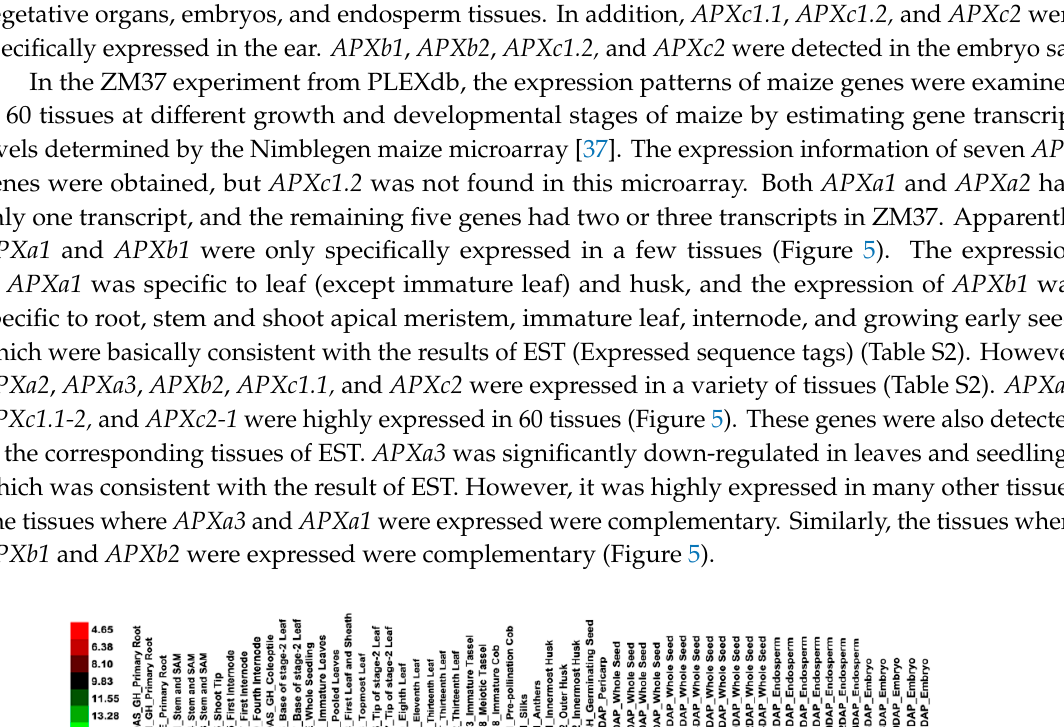
Figure 6. Expression patterns of maize APX s in response to Ustilago maydis infection and drought stres s . ( A – C ): The expression patterns of maize leaf APX s during infection with Ustilago maydis . ( D ): The expression pattern of maize leaf APX s from two maize inbred lines under drought stress. Han21: drought-tolerant, Ye478: drought-sensitive. MD: moderate drought, SD: severe drought. The experimental data were downloaded from ZM20 (Figure 6A), ZM24 (Figure 6B), ZM38 (Figure 6C), and ZM30 (Figure 6D) in PLEXdb [32]. Colors represent expression levels for each gene, which are either above (red), below (green), or at the mean expression level (black). Different treatments are mentioned on top, while the genes are mentioned on the right. Compared with the control, the expression level of APXa2 increased with the increase in the days of infection with Ustilago maydis (Figure 6A). The expression levels of APXc1.1 and APXc1.2 also